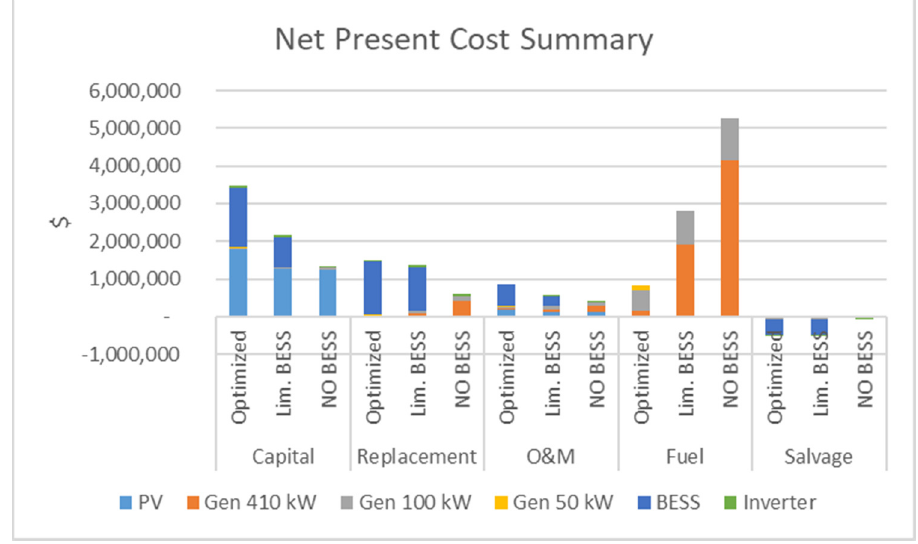
Figure 8. Net present cost summary.